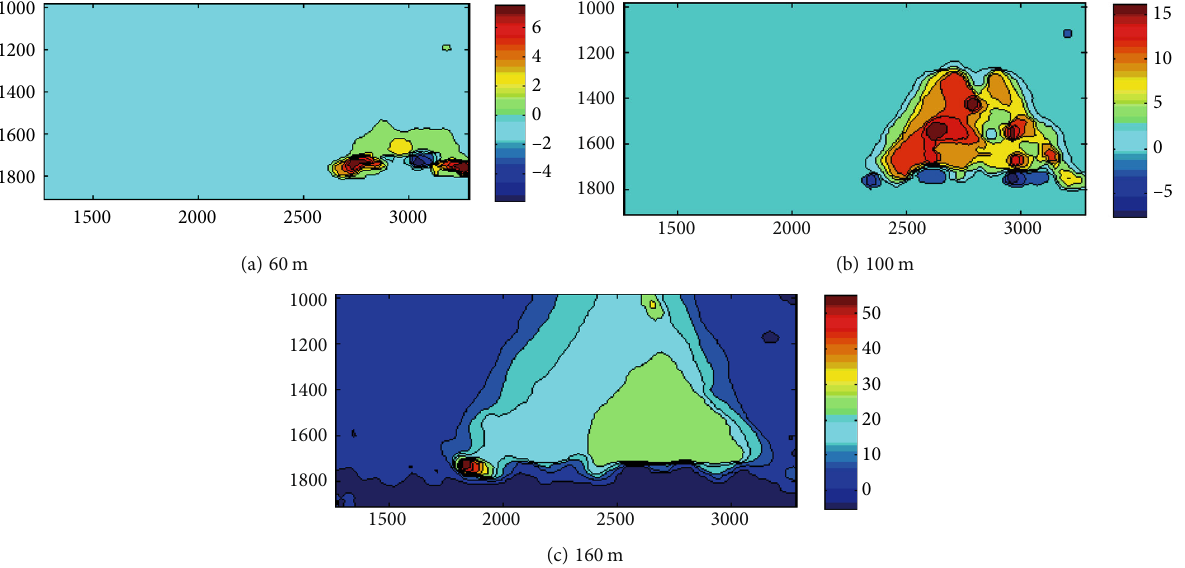
Figure 10: Nephogram of overlying strata displacement with excavation in a 1200 m mining depth